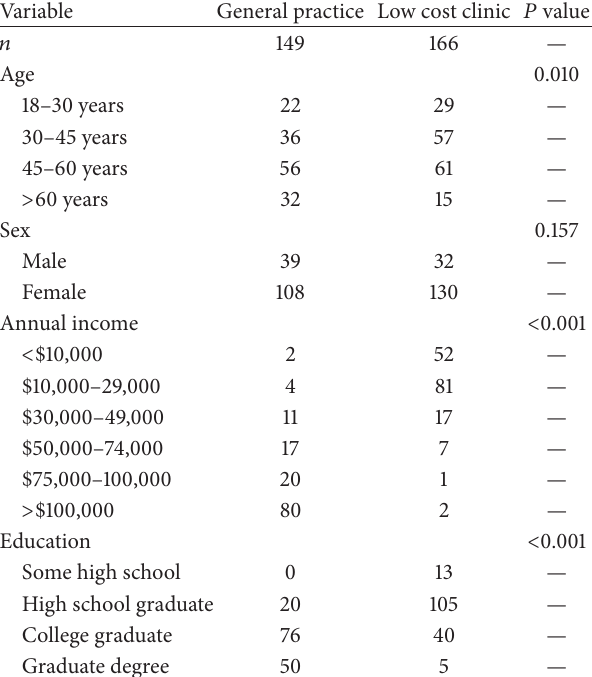
Table 1: Summary of owner demographics from 315 animals enrolled from two veterinary